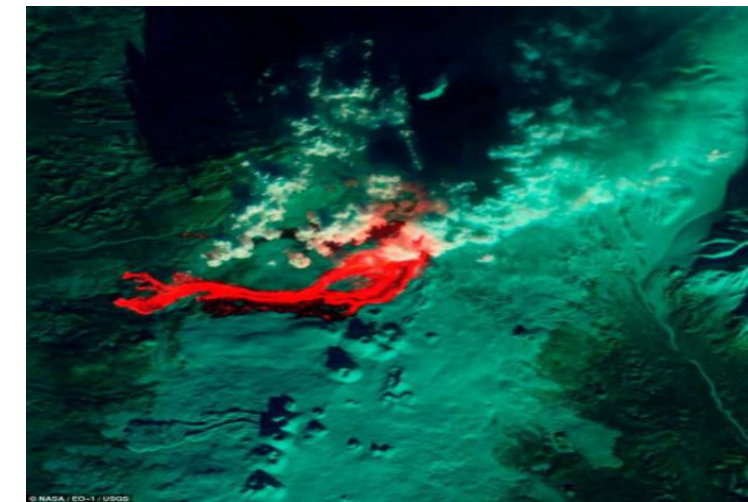
Figure 15 – Infrared image of Ploskiy Tolbachik